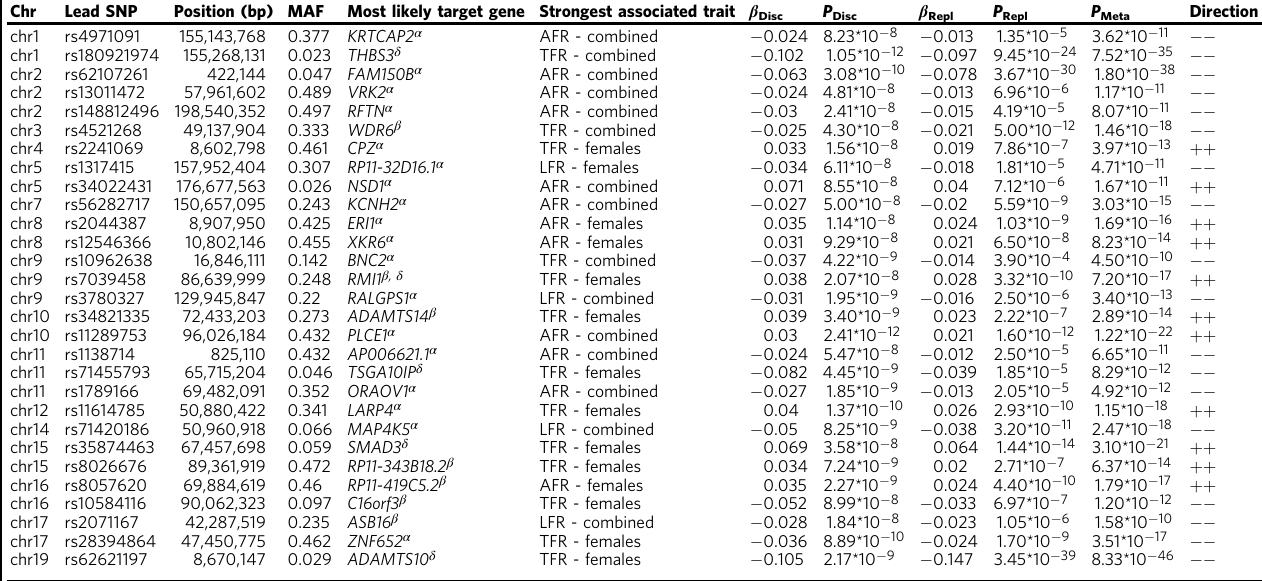
Table 1 Body fat ratio-associated loci that have not previously been associated with an anthropometric trait Chr Lead SNP Position (bp) MAF Most likely target gene Strongest associated trait β